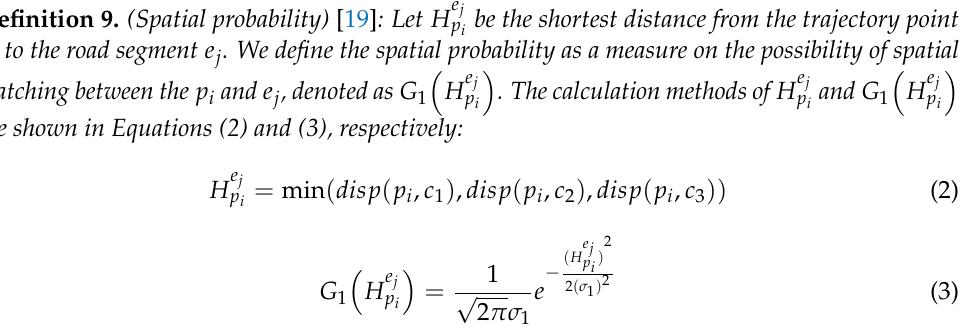
Figure 4. Selection of candidate road segments.